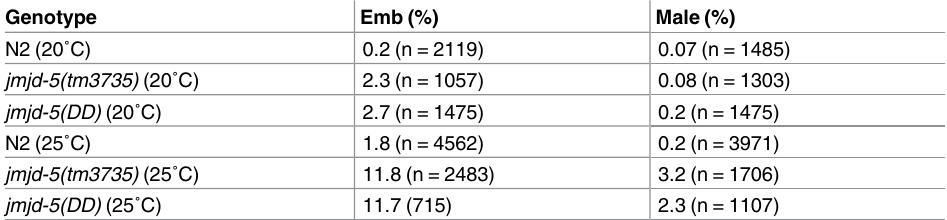
Table 1. Embryonic lethality and male production in jmjd-5 mutant animals. Embryonic lethality (Emb) and male productionof the indicatedgenotypes were measuredat 20˚C and after growingthe animalsat 25˚C for 5